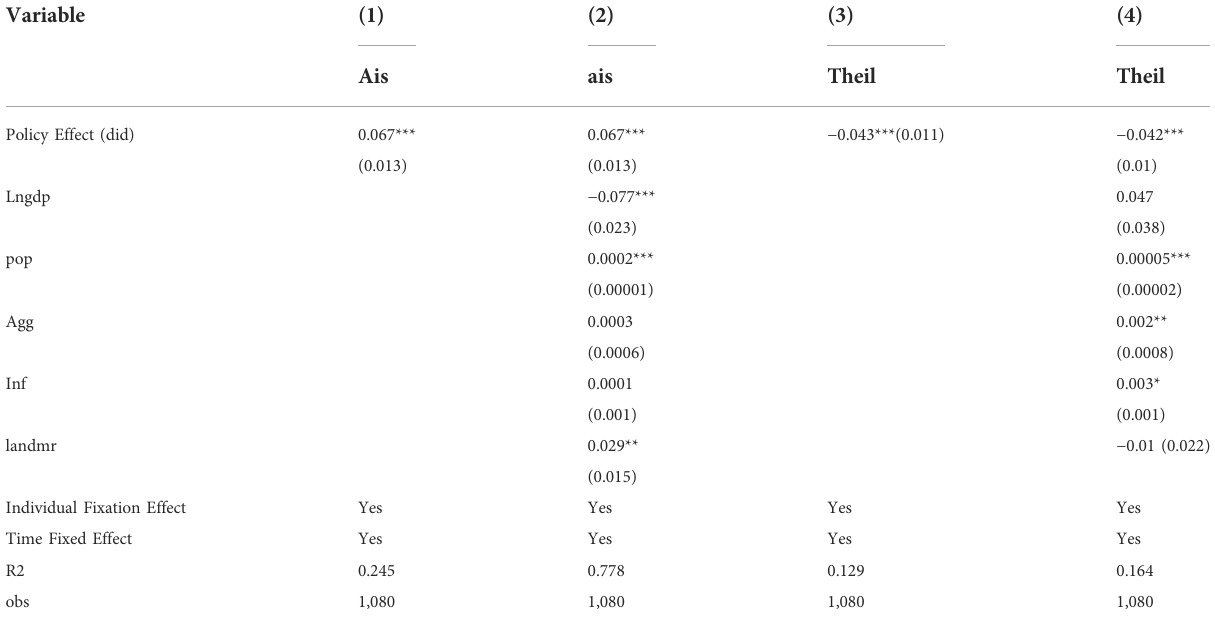
TABLE 4 Impacts of pilot relocation and reconstruction policies of old industrial districts on the upgrading of urban industrial structure.